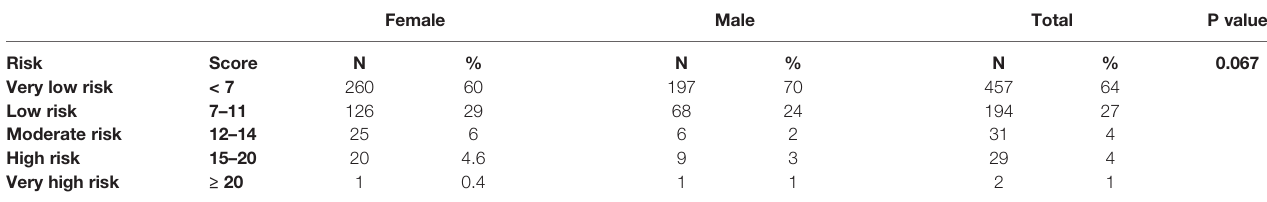
TABLE 3 | Risk levels of FINDRISC by